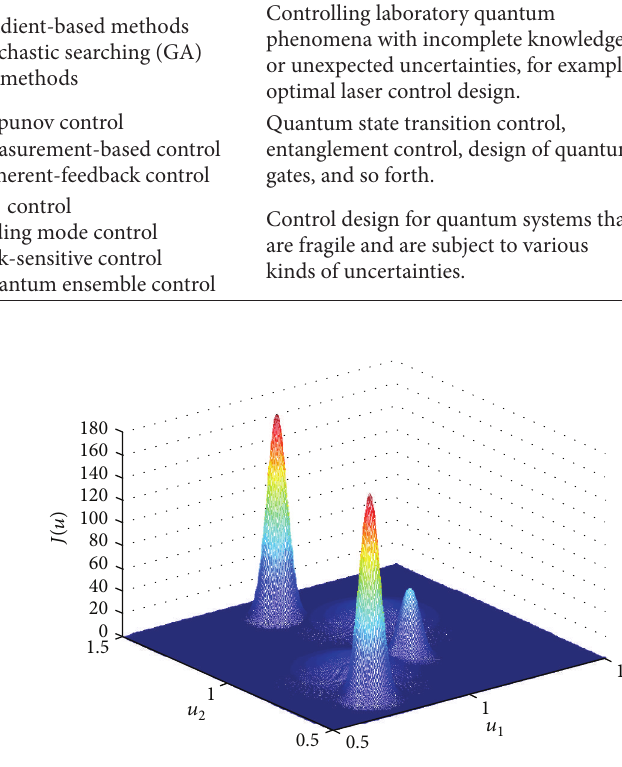
Figure 1: An example of quantum control